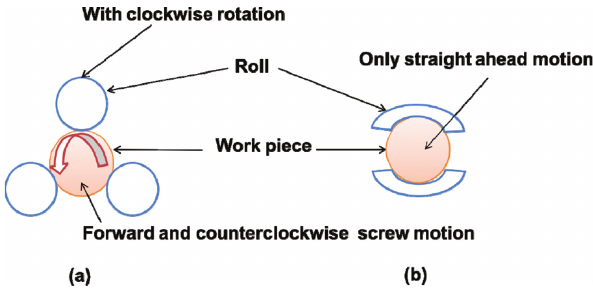
Figure 1: Diagram of the three-roll screw rolling system (a) and the conventional two-roll system(b).